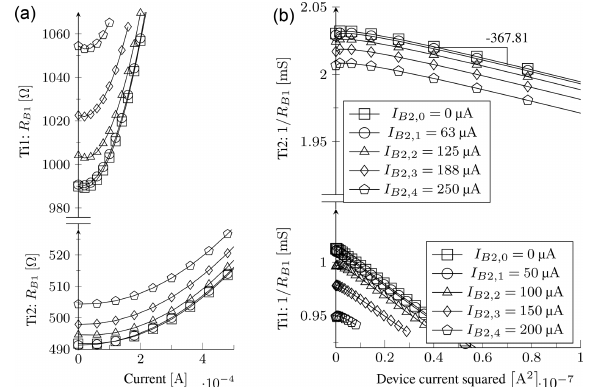
Figure 7. Experimental results of a parametric current sweep un- der vacuum conditions for the Ti thin-film devices indicating the resulting resistance of the first resistive element, R B 1 , while R B 2 is biased at different values as indicated in the legend entries. These results are also used to extract the beam thermal conductance. Note that the legends of (b) also apply to (a) but that Ti1 is presented at the top of (a) and at the bottom of (b) , as expected when comparing R to 1 /R . (a) Experimental R – I curves. (b) Experimental 1 /R – I 2